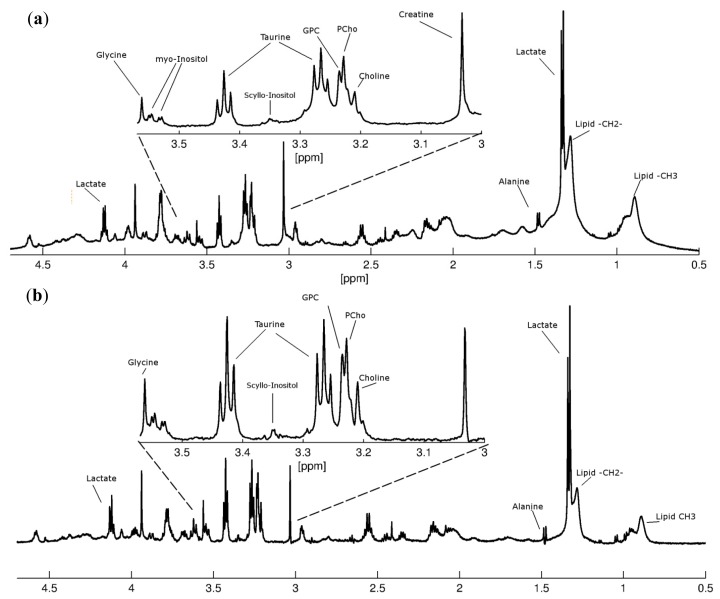
Representative proton HR-MAS spectra from a patient with brain metastasis from lung carcinoma obtained as (a) pre-saturated, single-pulse spectrum and (b) spin-echo spectrum, showing assignment of various metabolites. The enlarged ppm region 3.6–3.0 ppm shows more details of glycine (Gly), myo-inositol (myo-In), taurine (Tau), scyllo-inositol (scy-In), glycerophosphocholine (GPC), phosphocholine (PCho), choline (Cho) and creatine (Cr).